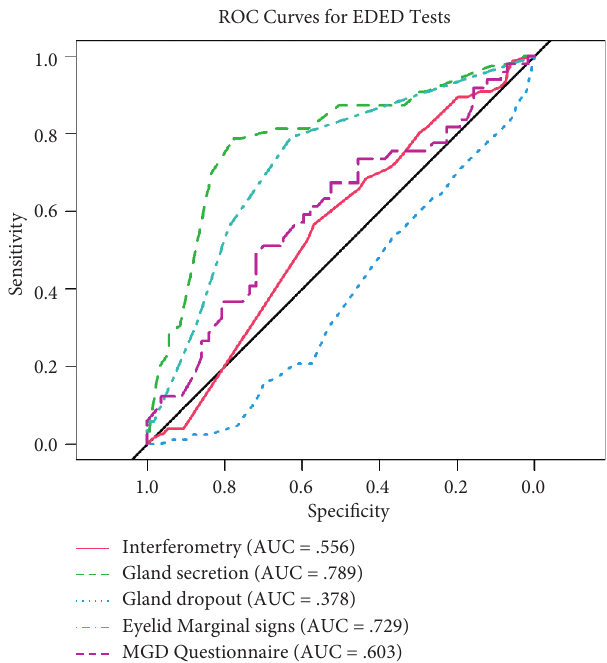
Figure 2: Receiver operating characteristic curves for EDE-specific tests, independent